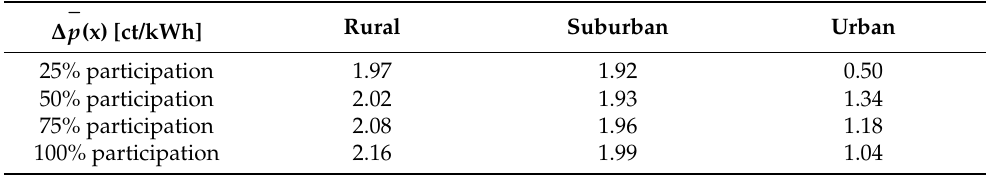
Table 4. Average price difference for both ‘economic optimum’ and ‘maximum grid-friendliness’ strategies of renewable energy community